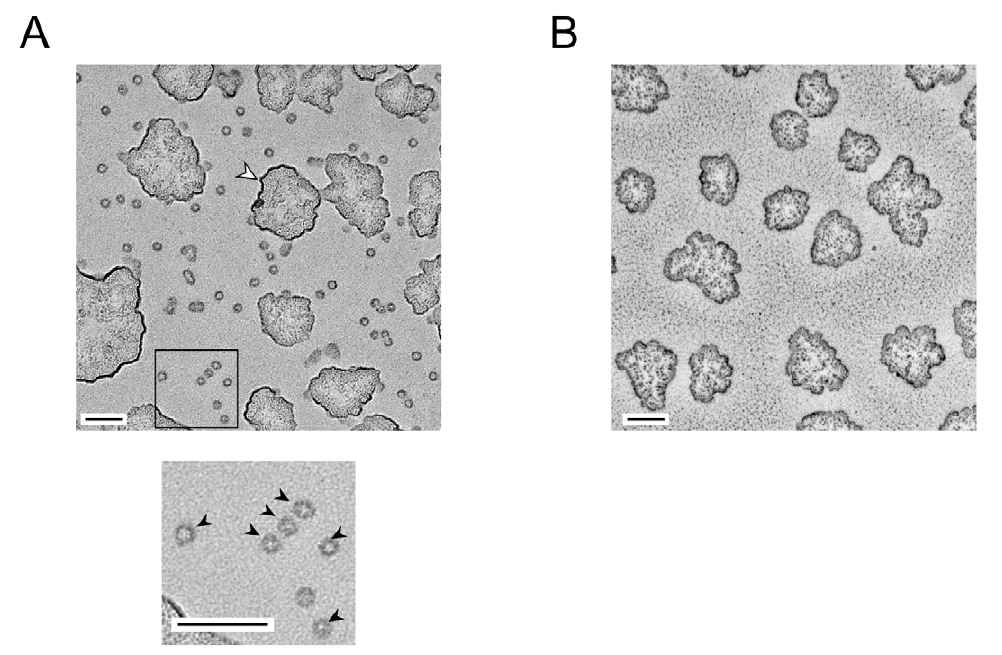
Figure 2. Rotary-shadowed electron micrograph of chaperonin immobilized onto the coverslip surface. (A) With immobilized chaperonin. The boxed area in the upper panel is enlarged in the lower panel . The particles comprise almost exclusively ring-shaped end-on views ( black arrowheads ). The white arrowhead indicates a cluster of glycerol. (B) Without immobilized chaperonin. The scale bars represent 100 nm.